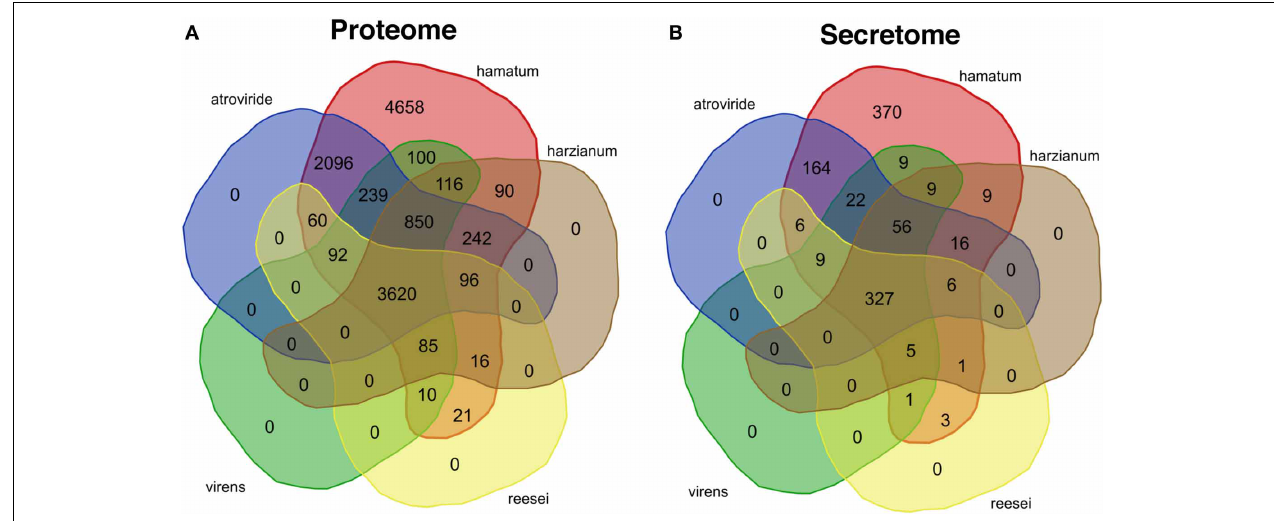
FIGURE 4 | Venn diagrams showing the conservation of the Trichoderma hamatum GD12 predicted proteome and secretome in previously sequenced Trichoderma species. BLASTP was used to search for similar sequences to each of the 12,391 predicted GD12 proteins. We performed BLASTP searches against the previously published predicted proteomes of T. atroviride , T. virens , T. reesei, and T. harzianum as well as against the GD12 predicted proteome. A protein was counted as conserved in a species if there was a BLASTP hit with least 80% amino acid sequence identity covering at least 90% of the query sequence. The predicted proteins and a subset comprising the